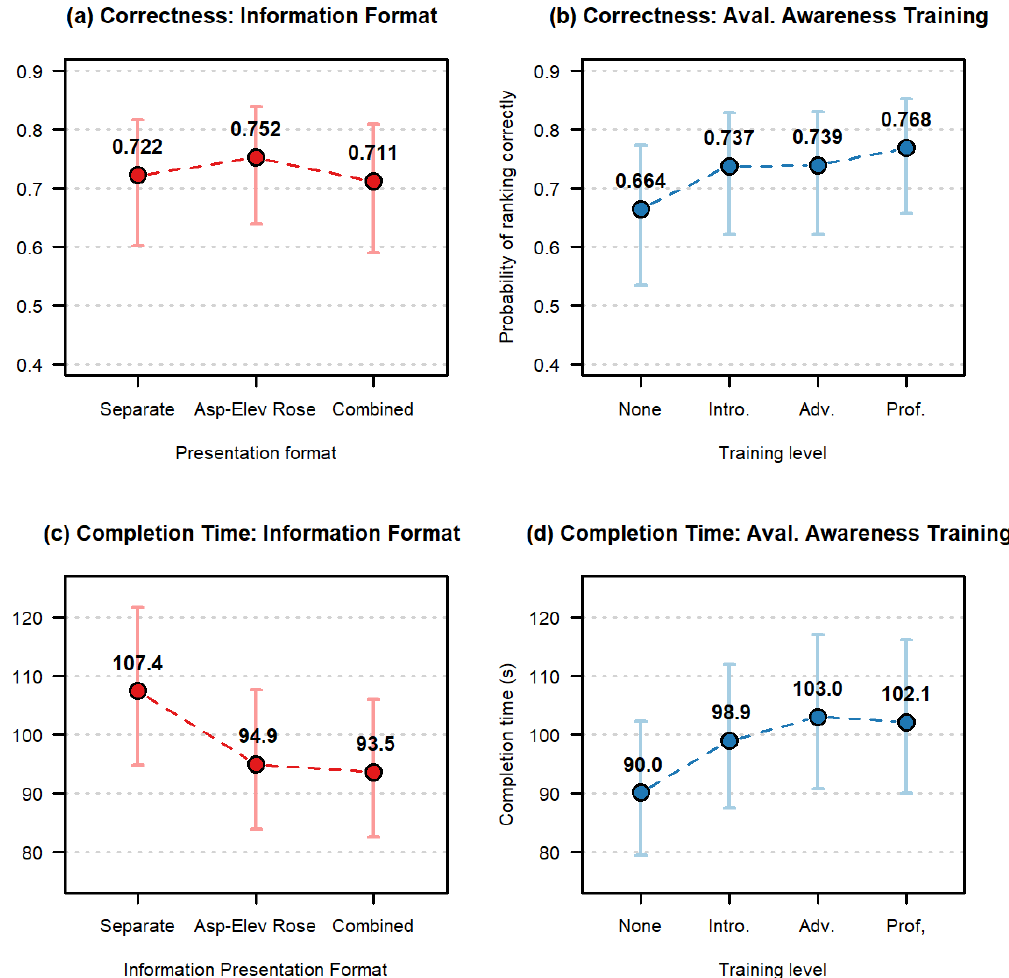
Figure 5. Effects plots illustrating the main effect for the presentation format and avalanche awareness training levels in the correctness and completion time model. Error bars represent 95% confidence intervals for probability of ranking correctly and completion time calculated from the subsample for the particular parameter